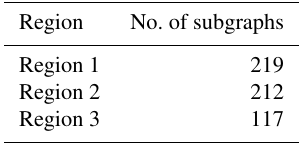
Table 2. Number of subgraphs obtained per